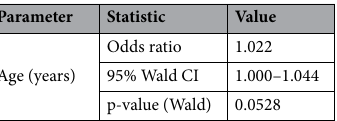
Table 4. Significant predictors for decreases in RFcsa ≥